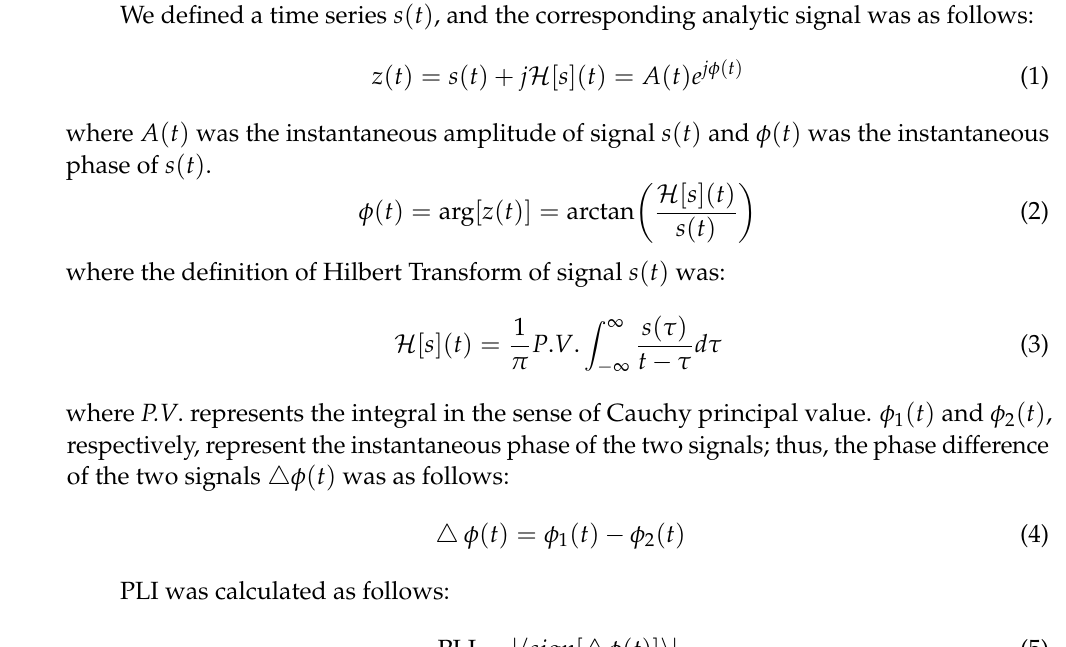
Figure 1. Schematic diagram of the functional connectivity in brain regions ( A ) and transhemispheric connectivity ( B ). The blue line denotes the connectivity between the electrode pairs as examples.